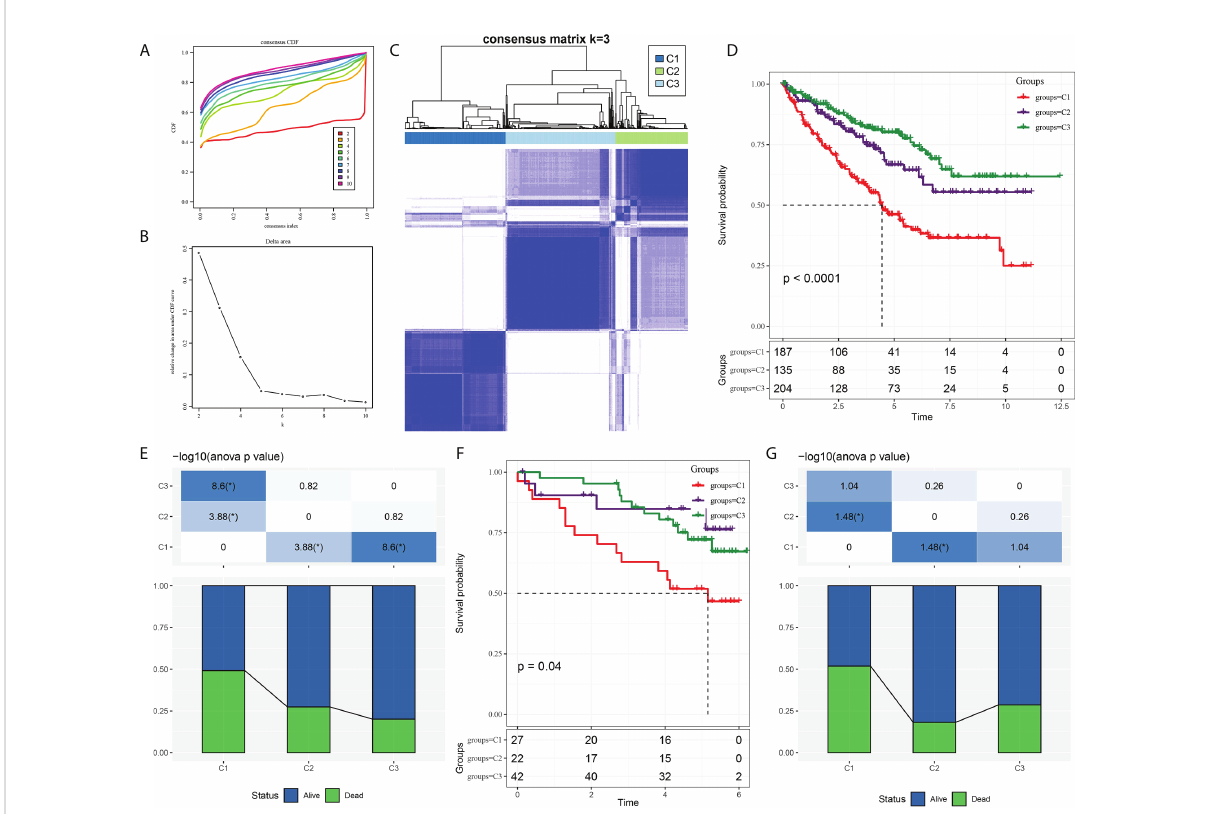
FIGURE 1 Three molecular subtypes of ccRCC were identi fi ed based on CS-related genes. (A) Consensus clustering cumulative distribution function (CDF) of k = 2 – 10. (B) The trend under the CDF curve when k = 2 to 9. (C) Heatmap depicted sample clustering at consensus k = 3. (D) The Kaplan – Meier curve of survival analysis for three molecular subgroups in TCGA-KIRC. (E) The proportion of patients who survived and died in each subgroup of TCGA-KIRC. (F) The Kaplan – Meier OS curves of three molecular subtypes in ICGC. (G) Survival and mortality of each molecular subtype in